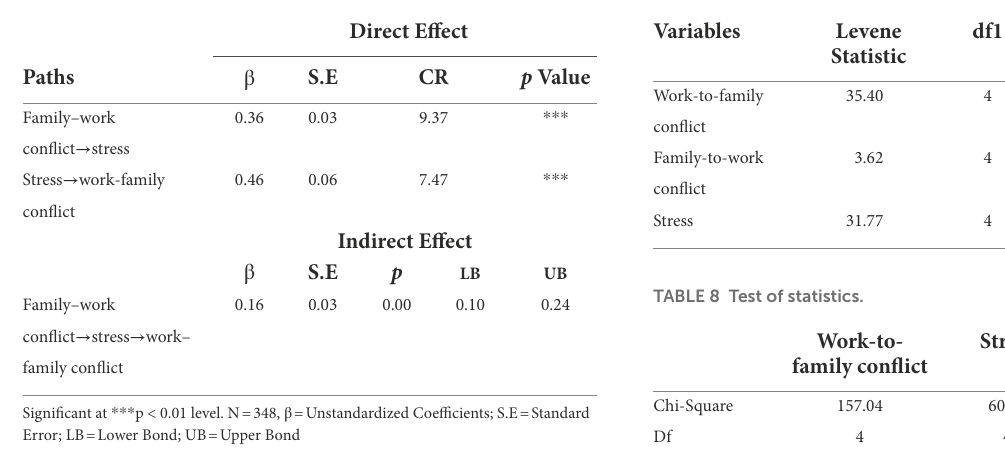
TABLE 5 Family to work conflict, stress, and work to family conflict.